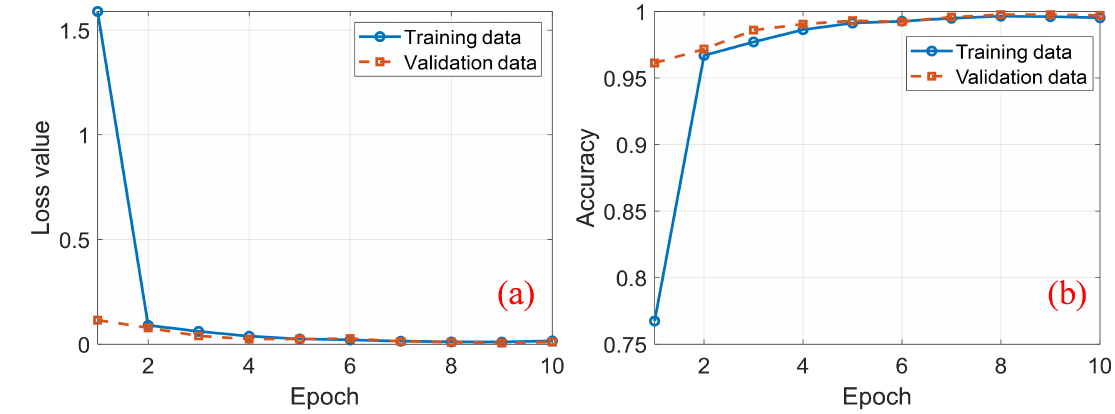
Figure 5. Loss function ( a ) and accuracy ( b ) of the training and validation data varying with the